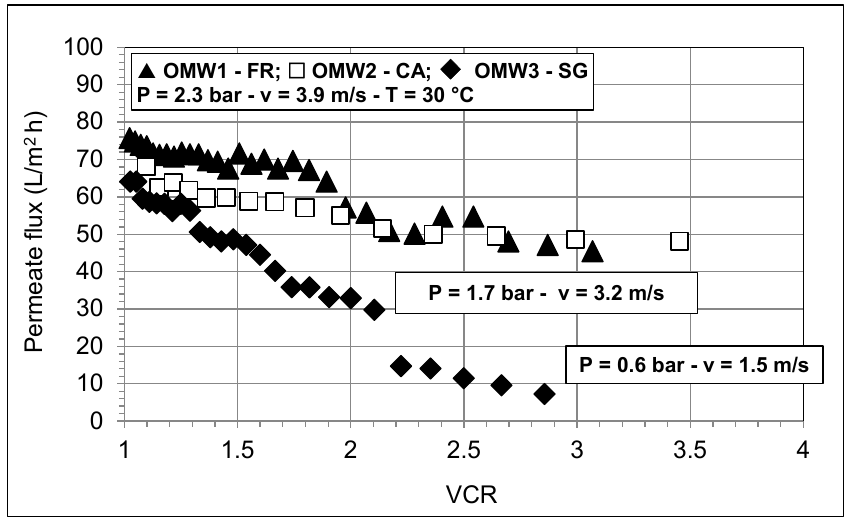
Figure 3. Permeate flux versus volume concentration ratio (VCR) during the MF tests with different OMWs.